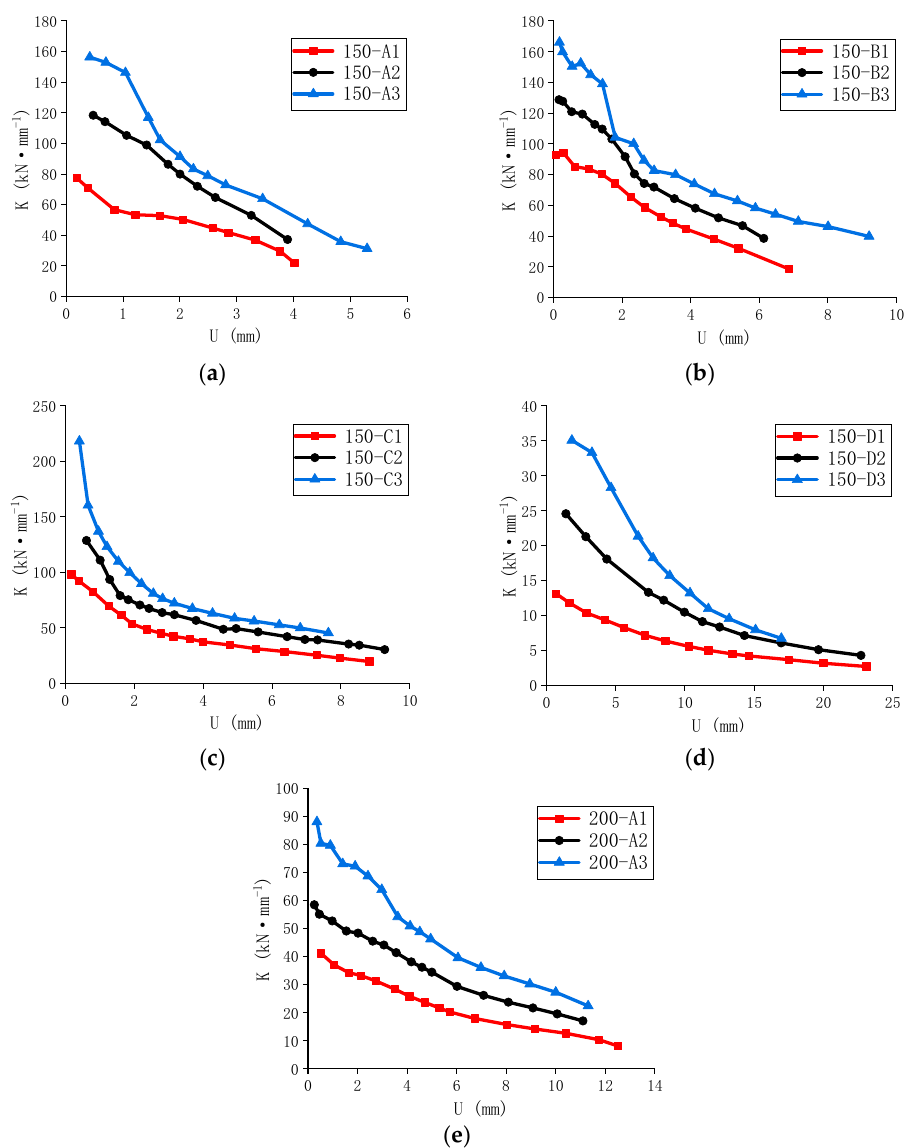
Figure 11. Skeleton curves of the specimens ( a ) 150–A, 150–A2, and 150–A3; ( b ) 150–B1, 150–B2, and 150–B3; ( c ) 150–C1, 150–C2, and 150–C3, ( d ) 150–D1, 150–D2, and 150–D3; ( e ) 200–A1, 200–A2,